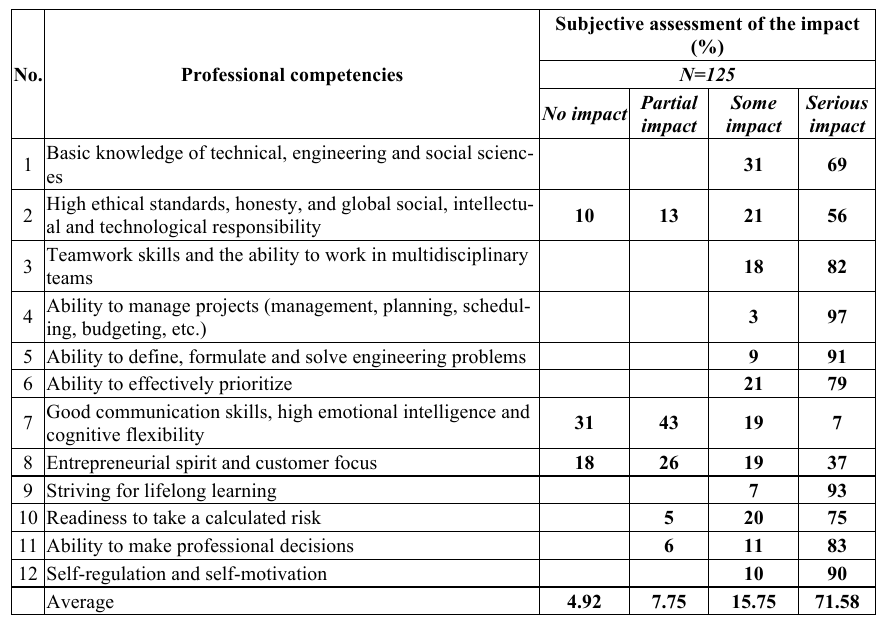
Table 4. Assessment of the impact of digital learning formats on the acquisition of key compe-